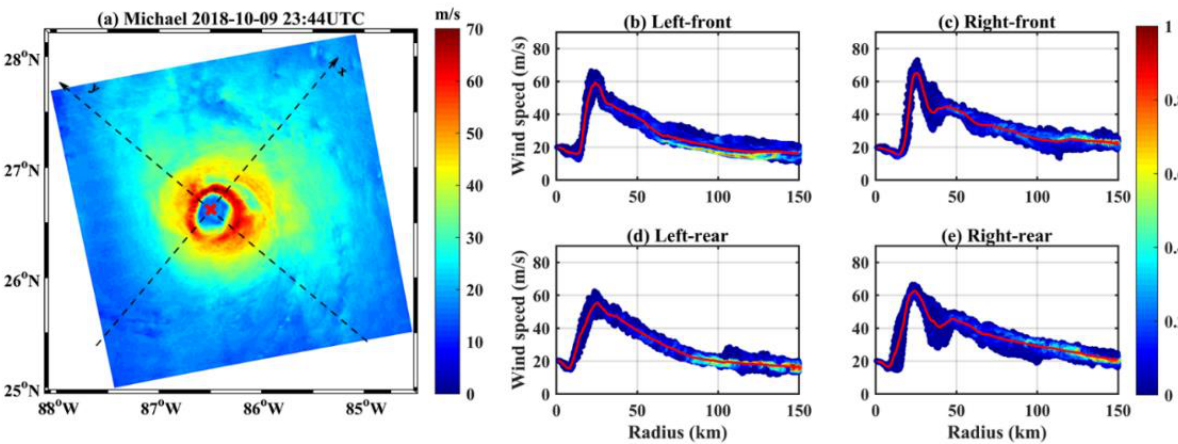
Figure 16. The same as Figure 11 but for Hurricane Michael at 23:44 UTC on 9 October 2018.